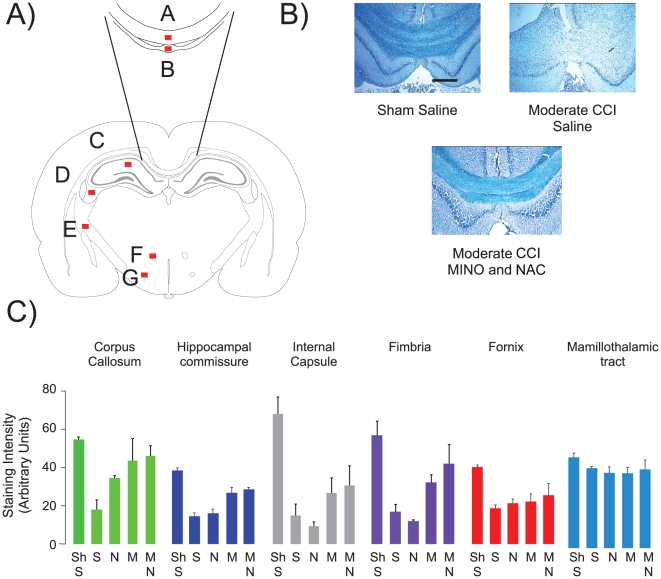
MINO plus NAC prevented myelin loss.
Panel A, Schematic of the regions of interest (ROIs) from a coronal section located −3.36 mm from Bregma [40]. The ROIs were: corpus callosum (A), dorsal hippocampal commissure (B), stratum radiatum (C), fimbria (D), internal capsule (E), fornix (F), mammilothalamic tract (G). Panel B, Representative images of corpus callosum and dorsal hippocampal commissure stained with luxol fast blue. B1, Sham-CCI-saline; B2 CCI-saline; B3, CCI-MINO plus NAC. The scale bar corresponds to 100µm.